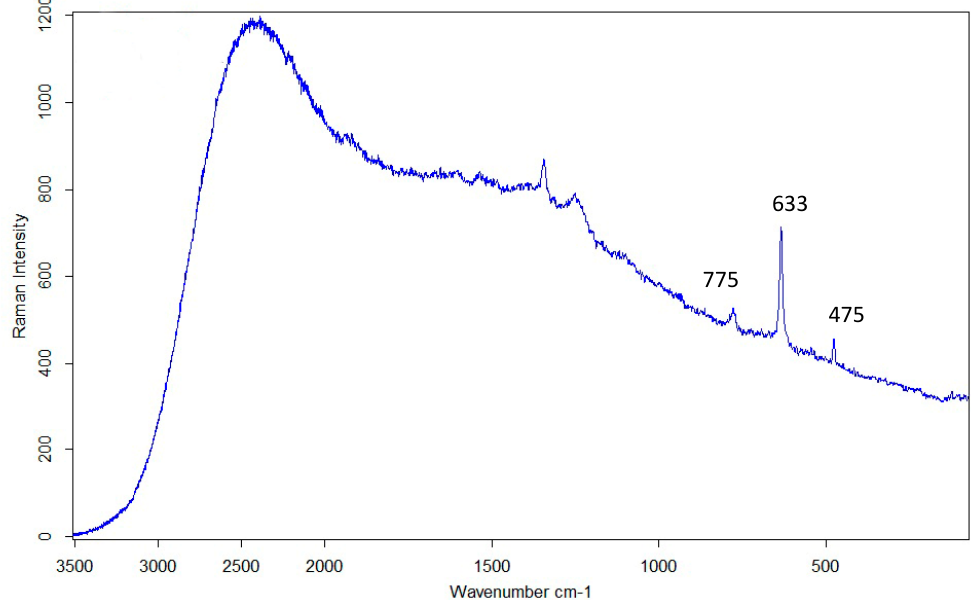
Figure 24. µ -Raman spectrum acquired on Sn-based crystals found in red glasses, with bands at